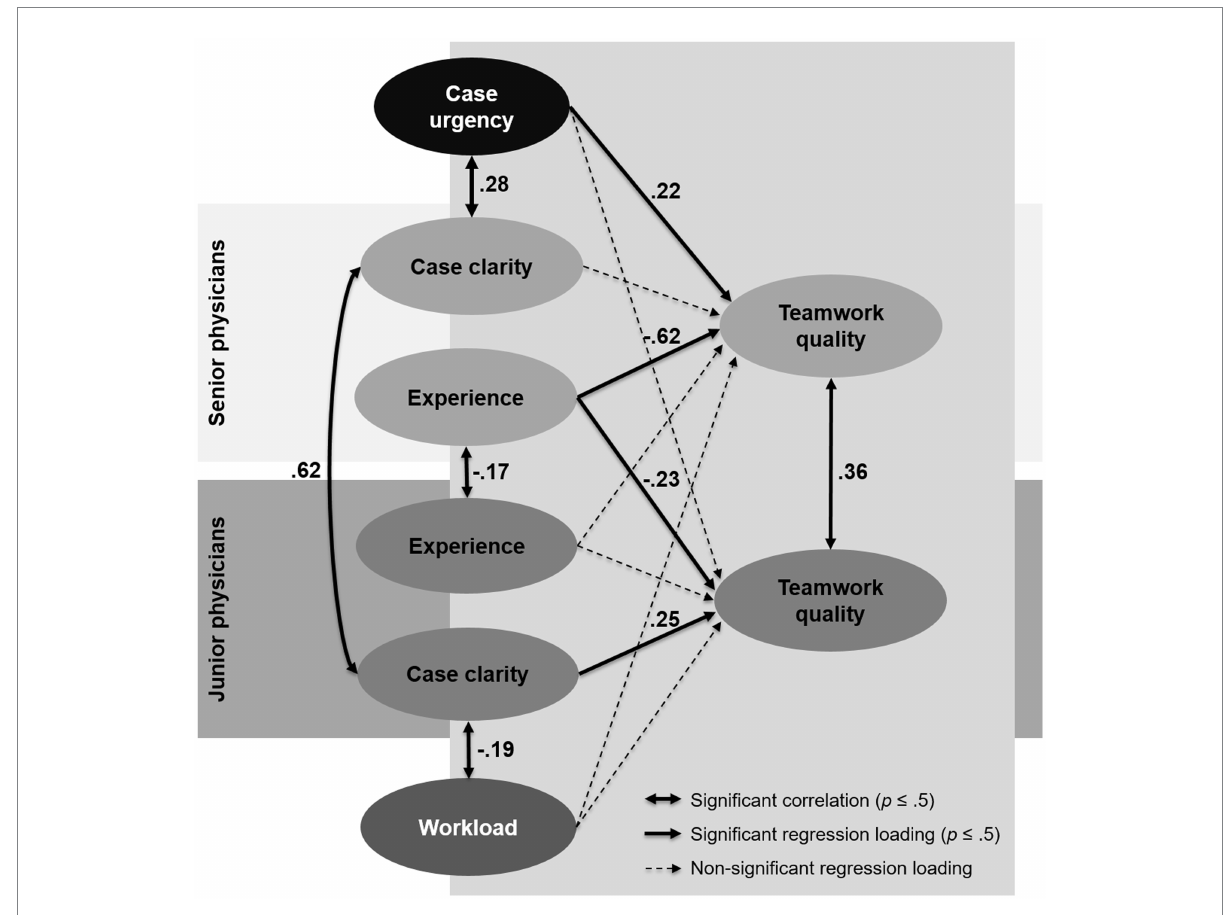
FIGURE 1 Relations of patient, physician, and context factors, as analyzed with a structural equation